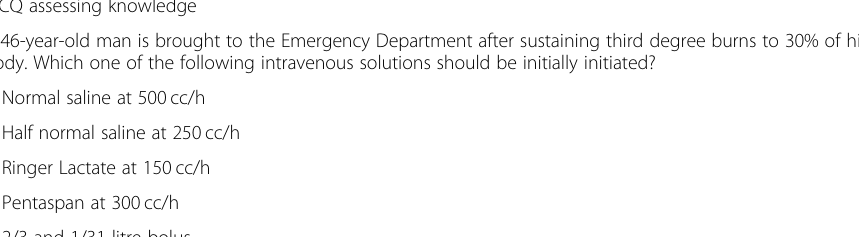
Table 1 Examples of MCQs assessing knowledge and application of knowledge MCQ assessing